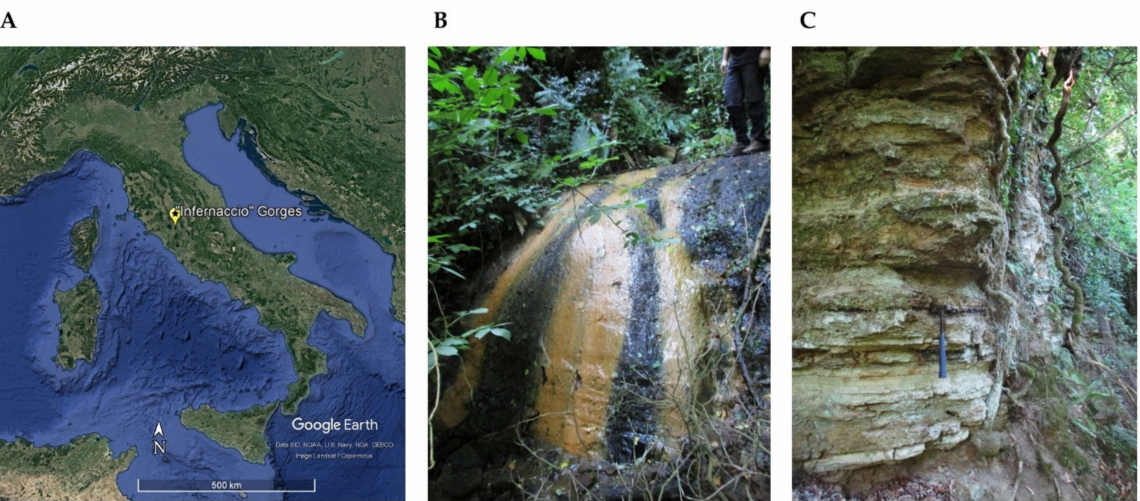
Figure 1. Location map (( A ), obtained from Google Earth Pro) and sampling sites of sample S1 and S2 (( B ), black crust on stream rocks and runoff water, respectively) and S3 (( C ), black crust within a gorge